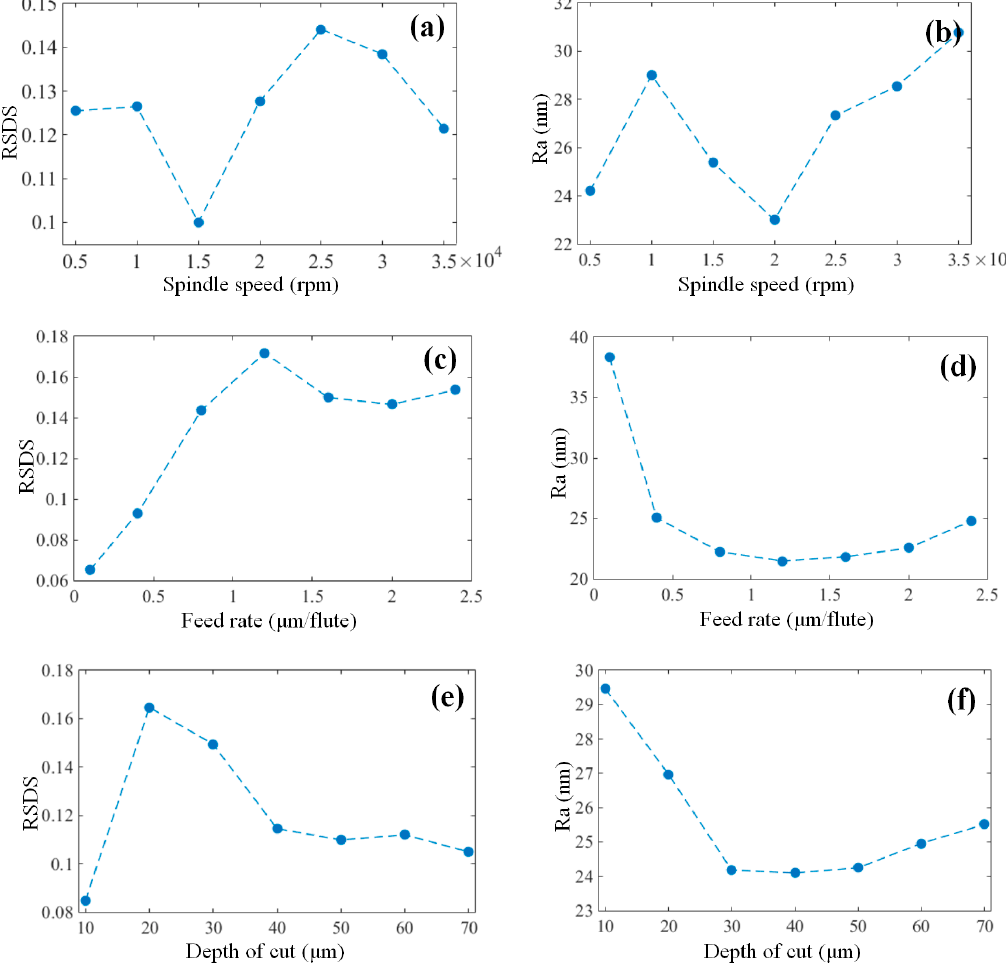
Figure 6. The trend of RSDS and Ra of the micro-milled grooves under different machining parameters with ( a , b ) spindle speed, ( c , d ) feed rate and ( e , f ) depth of cut.